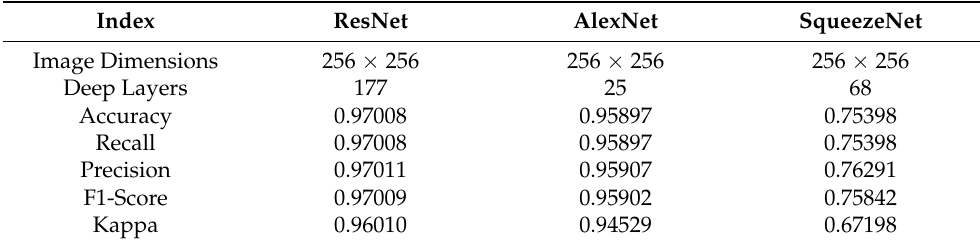
Table 4. The framework of Resnet, AlexNet, and SqueezeNet with transfer learning results.